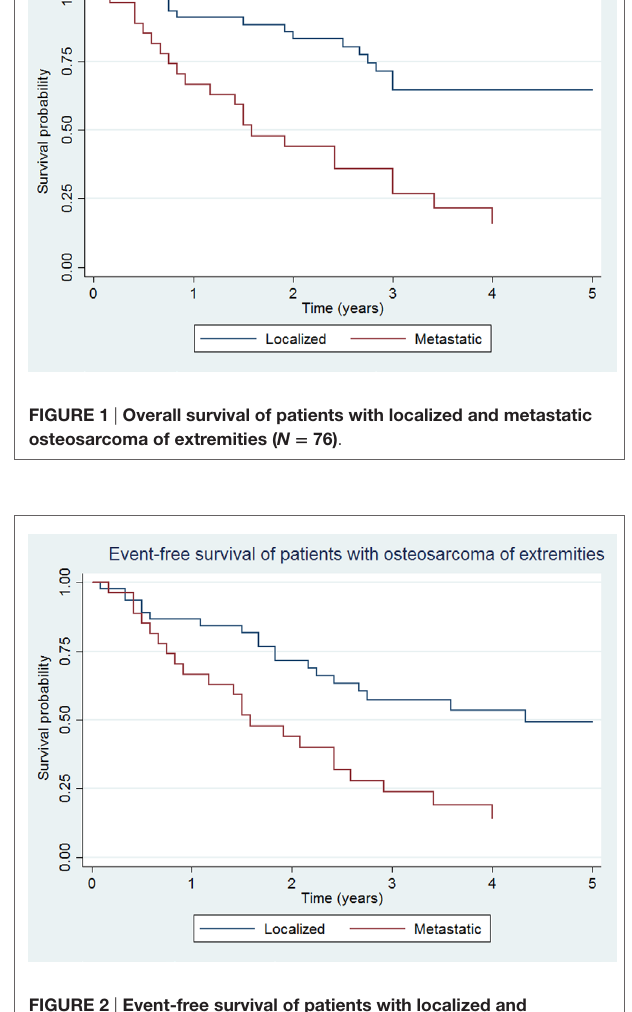
FigUre 2 | event-free survival of patients with localized and metastatic osteosarcoma of extremities ( N = 76) .